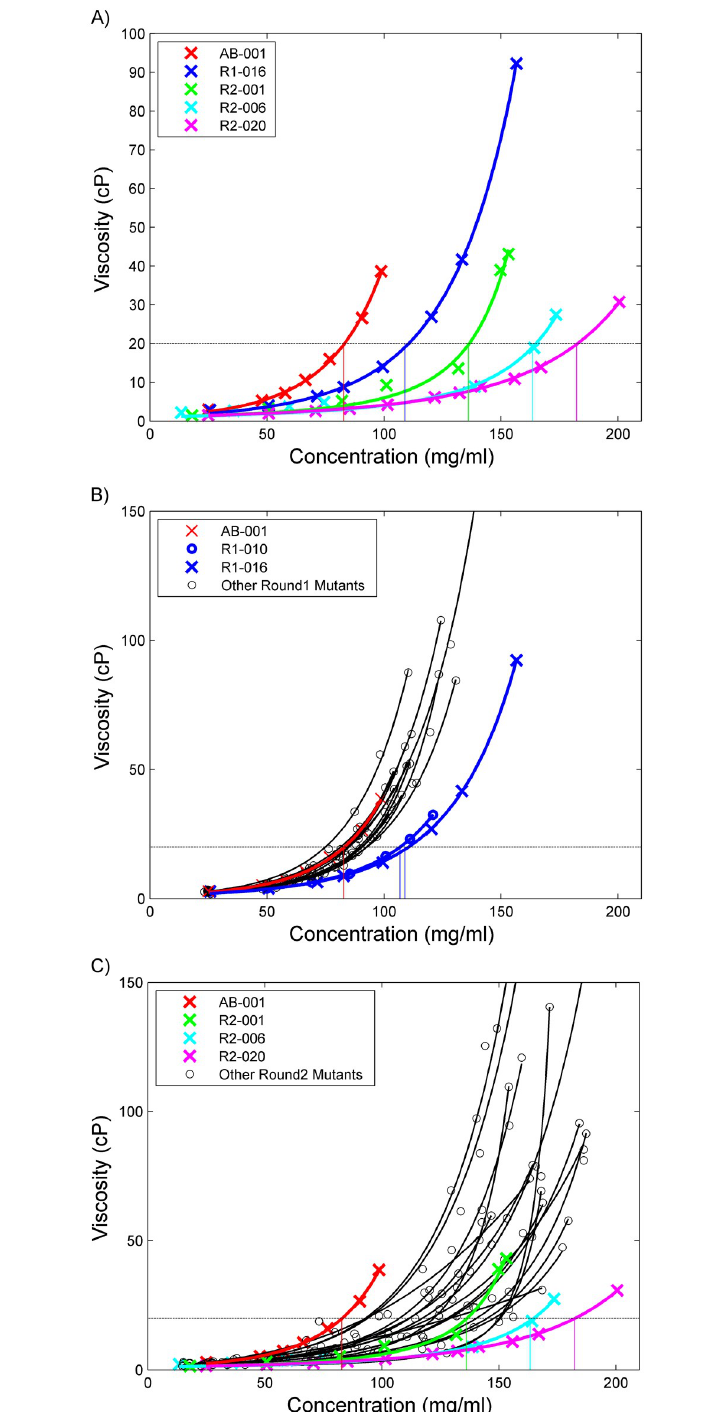
Fig 1. Viscosity analysis of anti-PDGF-BB antibodies. The viscosities of both rounds of antibodies are plotted against their concentrations with exponential curves fit using the Ross and Minton equation. [26] (a) Shows the viscosity for the parental AB-001 (red) along with the round 1 and round 2 mutants that had the biggest decrease in viscosity: R1- 016 (blue), R2-001(green), R2-006 (light blue) and R2-020 (magenta). Additionally, vertical lines show the concentration where the viscosity of these antibodies reaches 20 cP. (b) The viscosity data for Round 1 mutants are shown in black, along with the AB-001 data shown in red, and the best clones, R1-010 and R1-016, shown in blue.